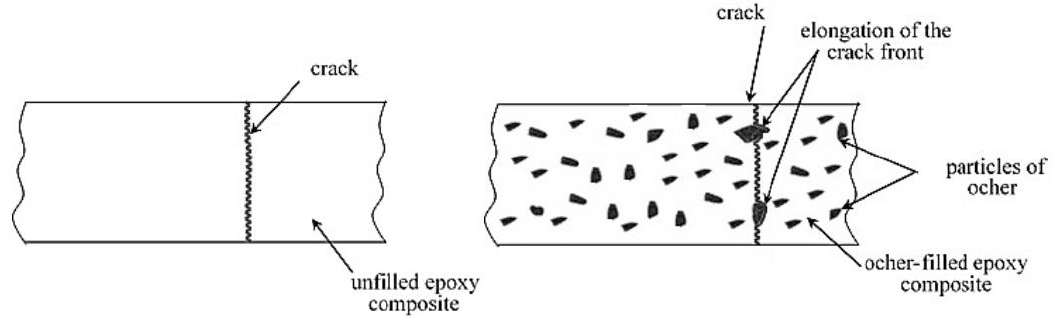
Figure 6. Model for the role of ocher as modifying additive in the epoxy composite.